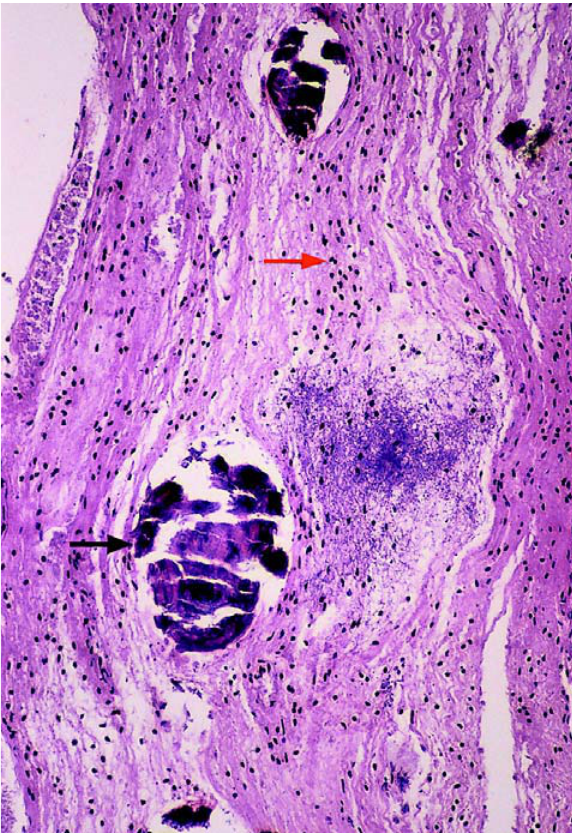
FIGURE 3- Pulp with complete necrosis, degeneration of blood vessels (blue arrow), cell nuclei (red arrow) and nerve bundles (white arrow) (H.E., original magnification 400X)